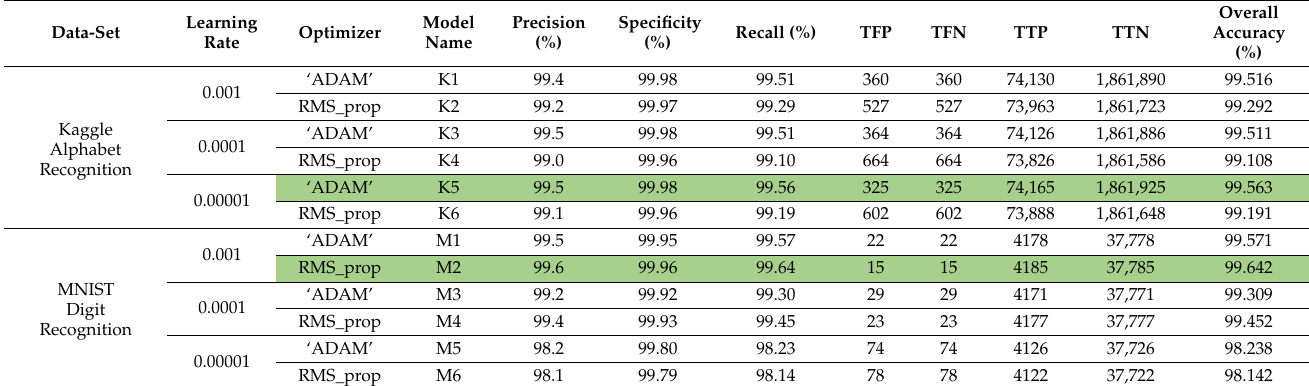
Table 2. Confusion matrix parameters of all the investigated models.